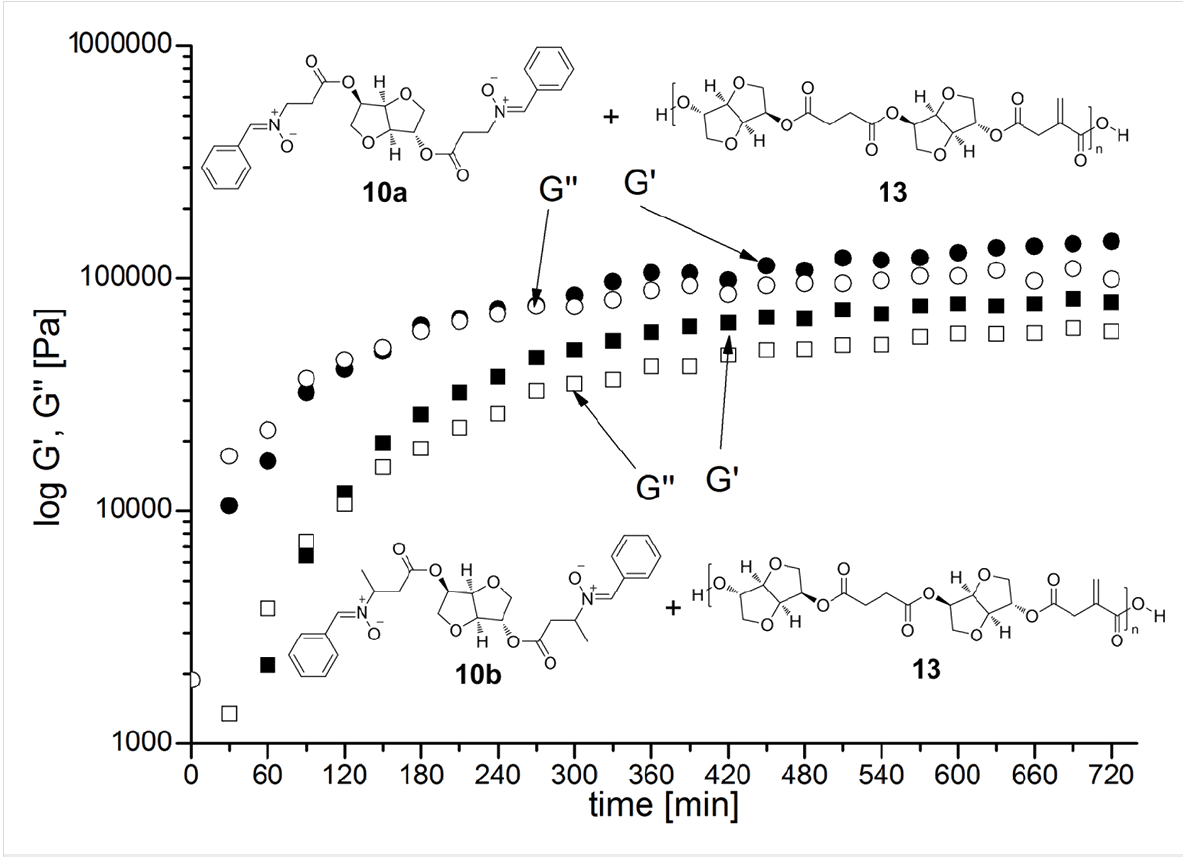
Figure 2: Oscillation measurements during thermal cross-linking of unsaturated polyester 13 with dinitrones 10a and 10b at 120 °C.